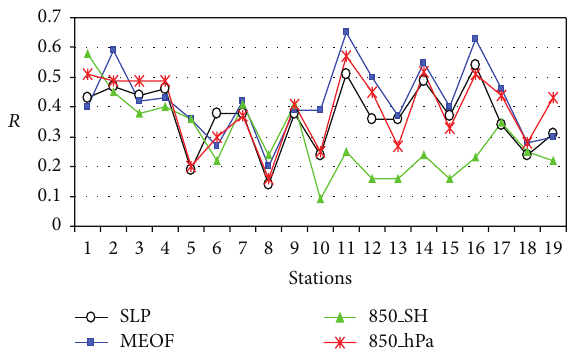
Figure 3: Correlation coefficients between observations and sim- ulations (ensemble mean of 100 realizations) for four predictors, represented by 10-PCs of SLP, geopotential at 850 hP, specific humidity at 850 hPa, and 10-PCs of MEOF